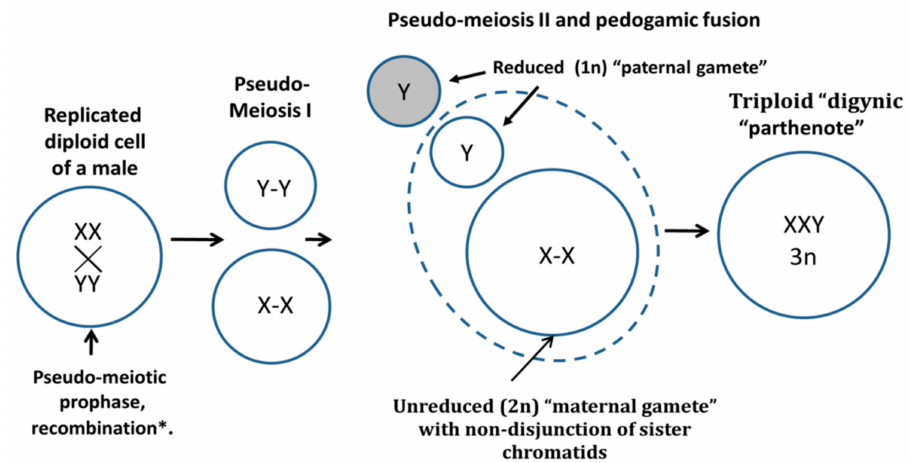
Figure 7. Schematic of the digyny-like formation of XXY triploid karyotypes in somatic male tumors. The reprogrammed male tumor cell triggers the aberrant molecular pathway of the pseudo-meiotic prophase from the G2-phase, undergoes recombination between cohered sisters and possibly also homologues, undergoes pseudo-meiosis I segregating maternal and paternal progenies with cohered sister chromatids, and triggers the reduction to haploidy of the “paternal gamete” in the pseudo-meiosis II and its pedogamic fusion with the unreduced diploid “maternal gamete”, resulting in triploid “digynic